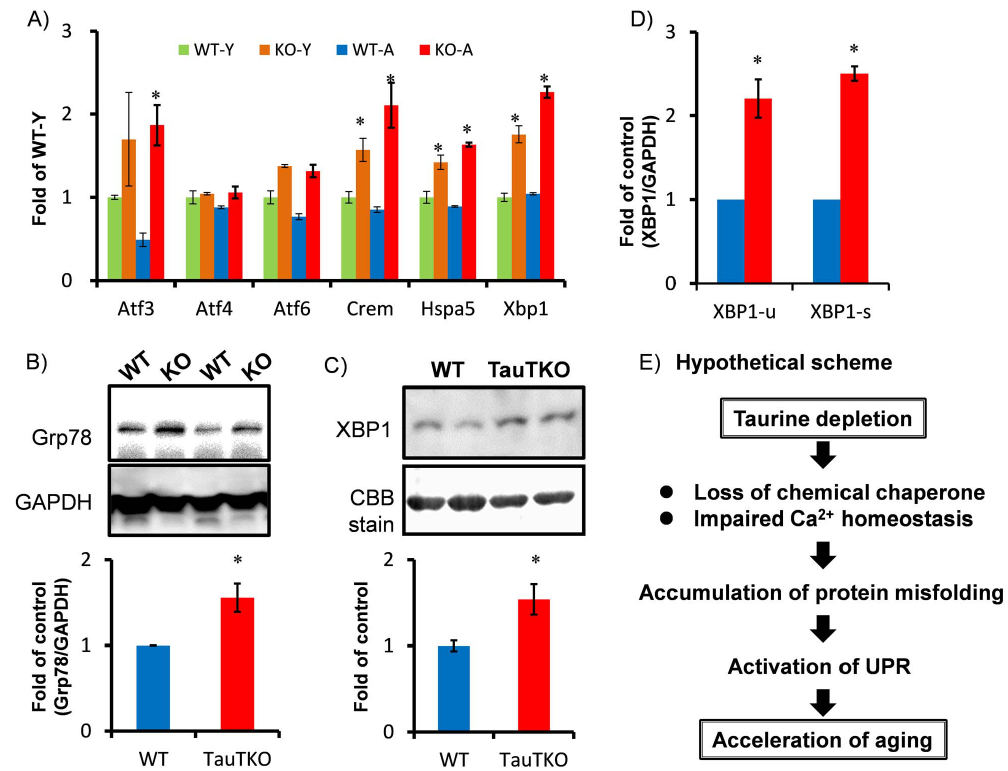
Figure 4. Activation of the unfolded protein response in TauTKO muscle. A) Microarray data show upregulation of UPR-related genes, including ATF3, 6, Crem, Hspa5 (Grp78) and Xbp1, in TauTKO muscle. n=3. B) Western blot reveals an induction in Grp78 protein expression in old TauTKO muscle. n=5. C) Western blot reveals an induction in nuclear XBP1 protein expression in old TauTKO muscle. n=4. D) Real-time PCR analysis for unspliced and spliced XBP1 (XBP1-u and XBP1-s, respectively) mRNA in WT and TauTKO mice show a significant induction in both total and spliced (active form) of XBP1 mRNA. n=5. *;p , 0.05 vs WT. E) Our data hypothesize that taurine depletion in skeletal muscle may lead the activation of UPR due to the accumulation of unfolded proteins, which in turn accelerates tissue aging in TauTKO